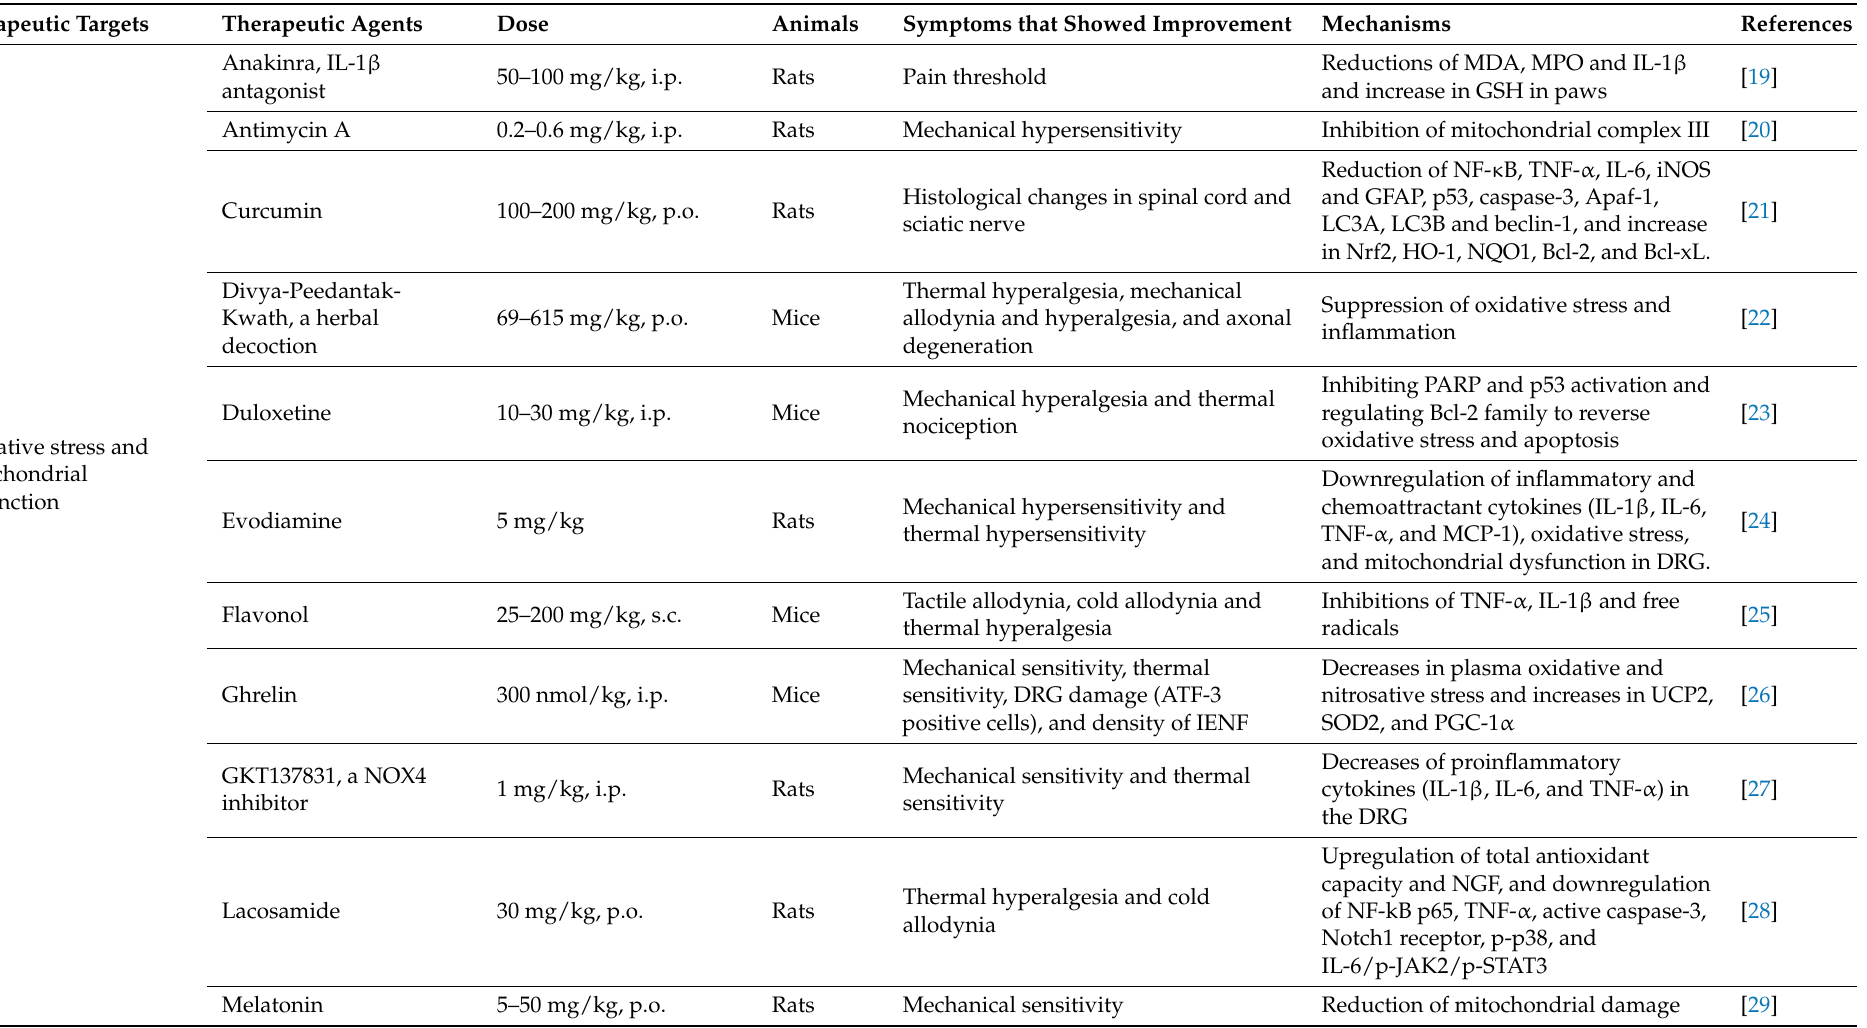
Table 1. The therapeutic agents for paclitaxel-induced peripheral neuropathy in preclinical